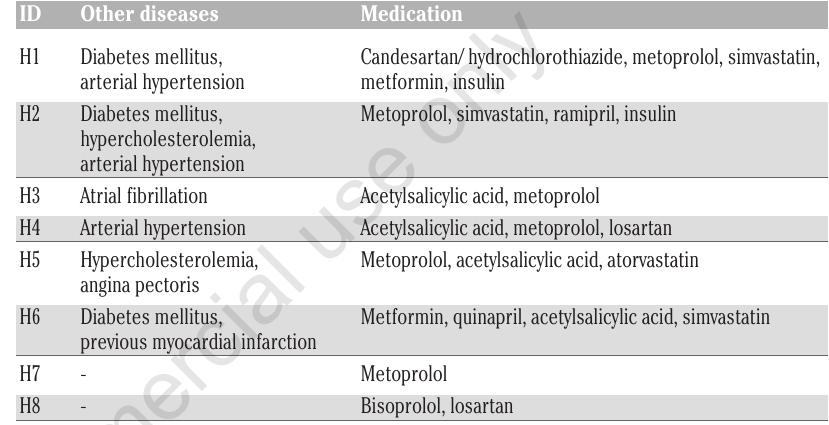
Table 3. Patient medications and other